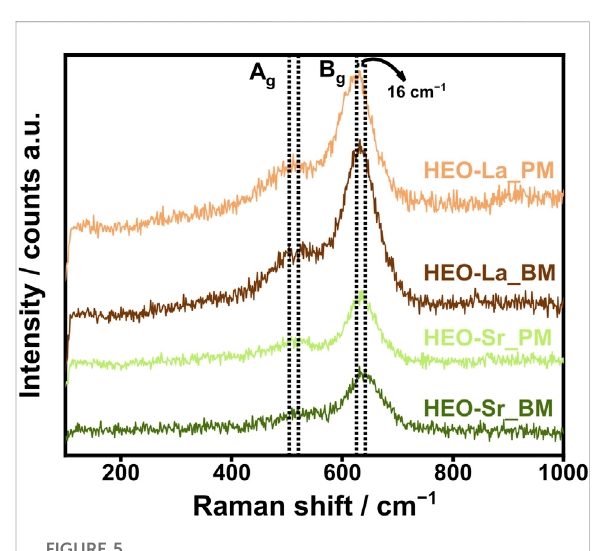
FIGURE 5 Raman spectra of HEO-La and HEO-Sr, synthesized using ball milling (BM) and Pechini method, obtained using a He – Ne laser ( λ = 633 nm). The A g vibration mode for O-B-O groups lies at ~ 510 cm − 1 , whereas B g band lies at ~ 622 cm − 1 . HEO-La_PM and HEO-Sr_PM were calcined at 1,200 ° C for 12 h in